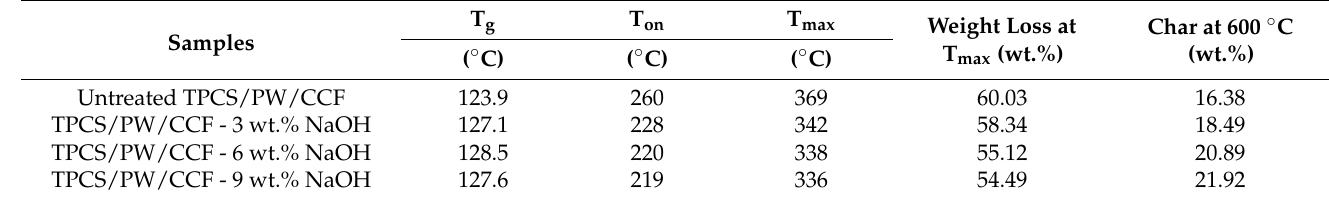
Table 2. TGA and T g results of treated and untreated TPCS/PW/CCF composites.